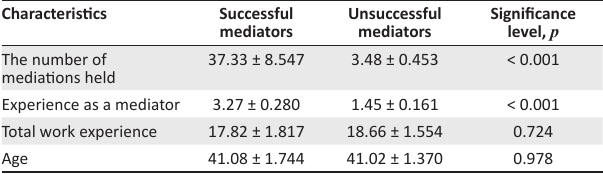
TABLE 3: Characteristics of successful and unsuccessful